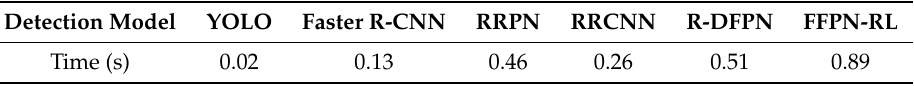
Table 4. Average processing time on each testing image for different ship detection